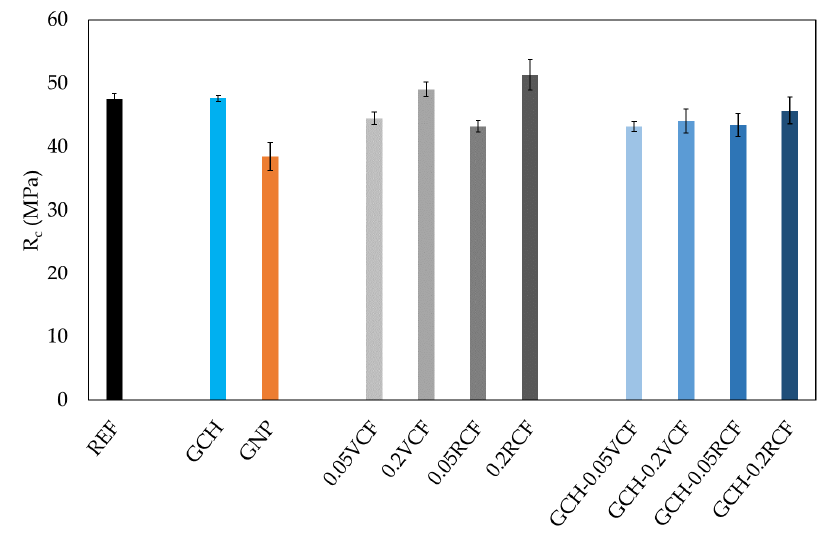
Figure 8. Compressive strength (R c ) of mortars after 28 days of curing.